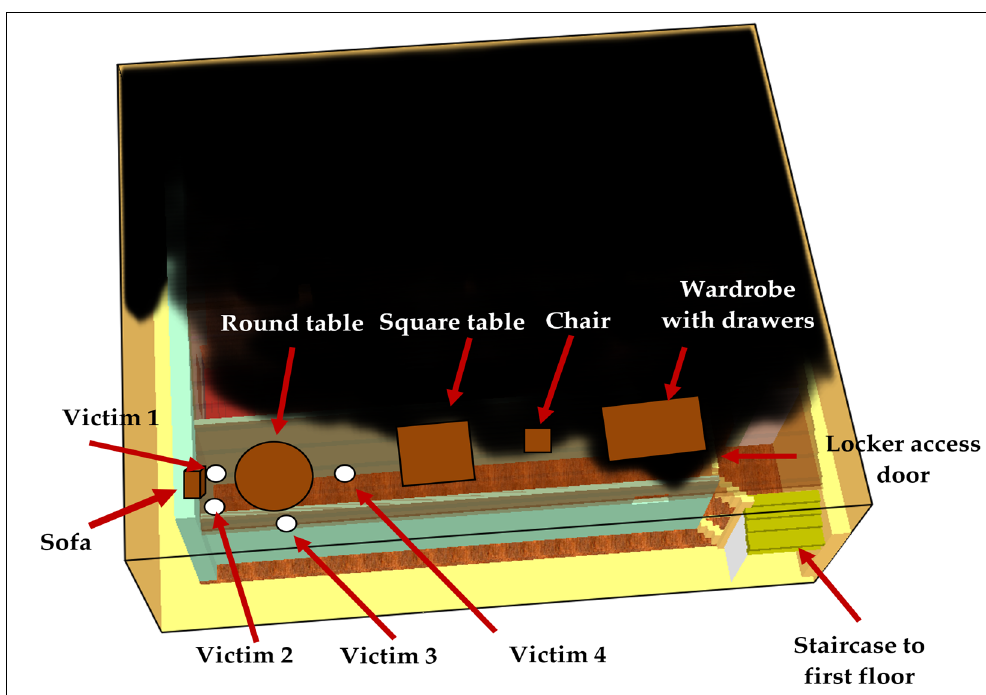
Figure 19. The advance of smoke and toxic gases from the wall with the fire source towards the locker room and the access staircase to the first floor.